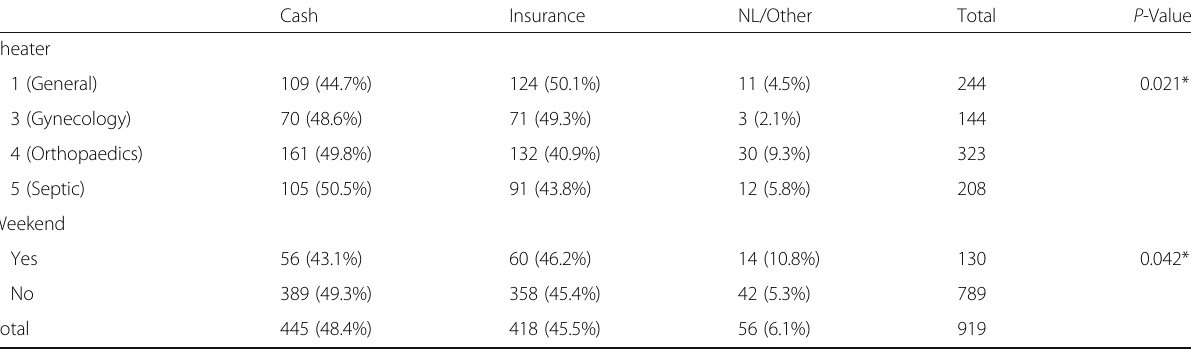
Table 7 Elective room number of cases using various payment